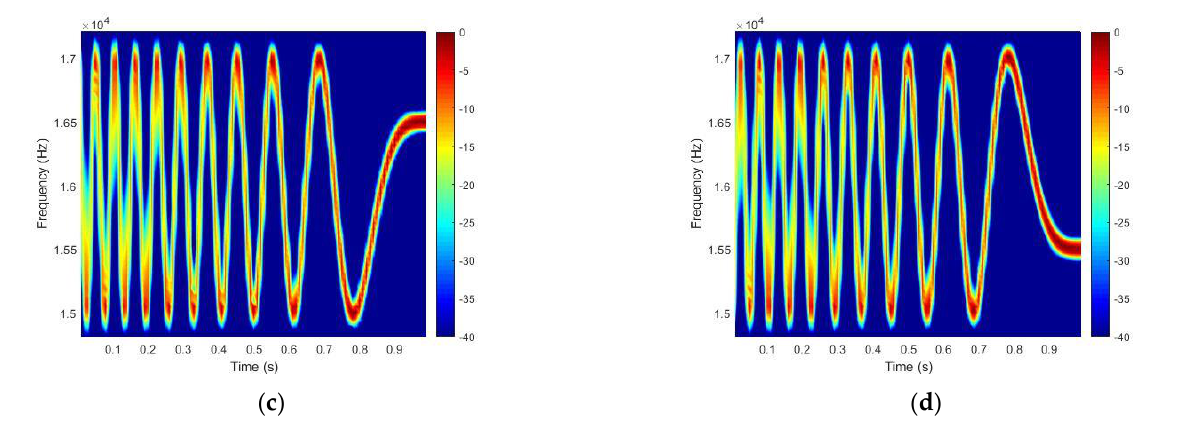
Figure 1. Four types of GSFM waveform spectrograms: ( a ) forward type, ( b ) forward-time/flipped-frequency, ( c ) reverse time, and ( d ) reverse-time/flipped-frequency.